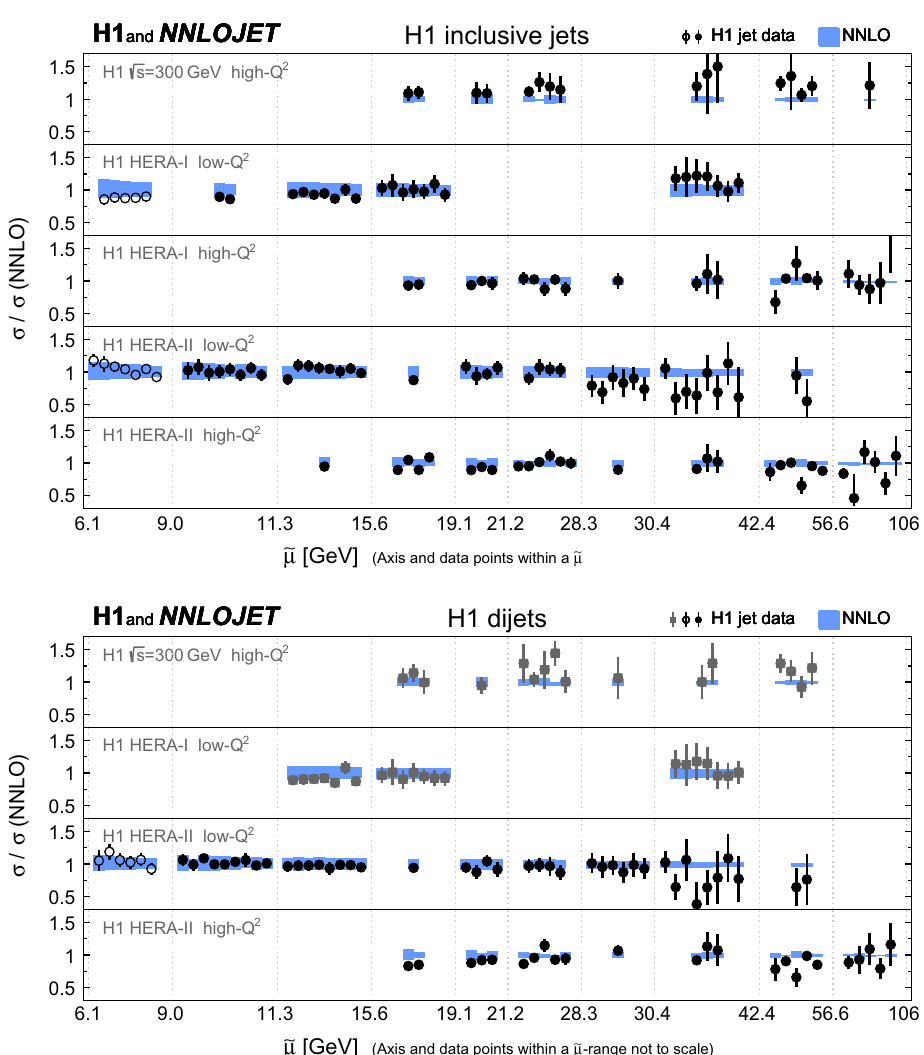
Fig. 12 Ratio of inclusive jet (upper panel) and dijet cross sections (lower panel) to NNLO predictions obtained with the fitted value α ( m ) = 0 . 1157. Data points are ordered according to their scale s Z ˜ μ and are displayed on the horizontal axis within the respective ˜ μ - interval. Within a single interval multiple data points are displayed with equal horizontal spacing and are thus not to scale. The displayed inter- vals reflect the choices made for the studies of the running of the strong